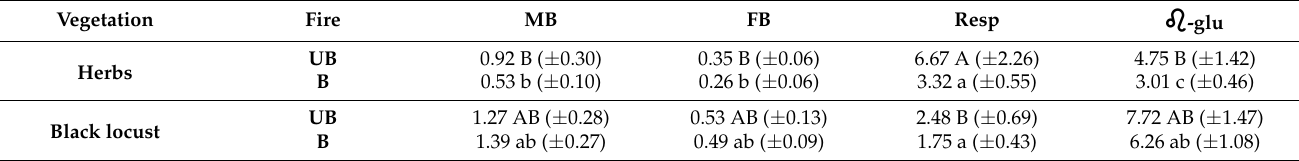
* p < 0.5. Different capital and small letters indicate significant differences (at least, p < 0.05, Kruskal–Wallis test) in soil characteristics among vegetation cover types, respectively, at unburnt and burnt sites. Asterisks indicate statistically significant differences (at least, p < 0.05, Wilcoxon test) in soil characteristics between unburnt and burnt sites covered by the same vegetation cover type. Table 3. Mean values ( ± st. err.) of microbial biomass (MB, expressed as mg C g − 1 d.w.), fungal biomass (FB, expressed as mg g − 1 d.w.), basal respiration (Resp, expressed as mg CO 2 g − 1 d.w.)